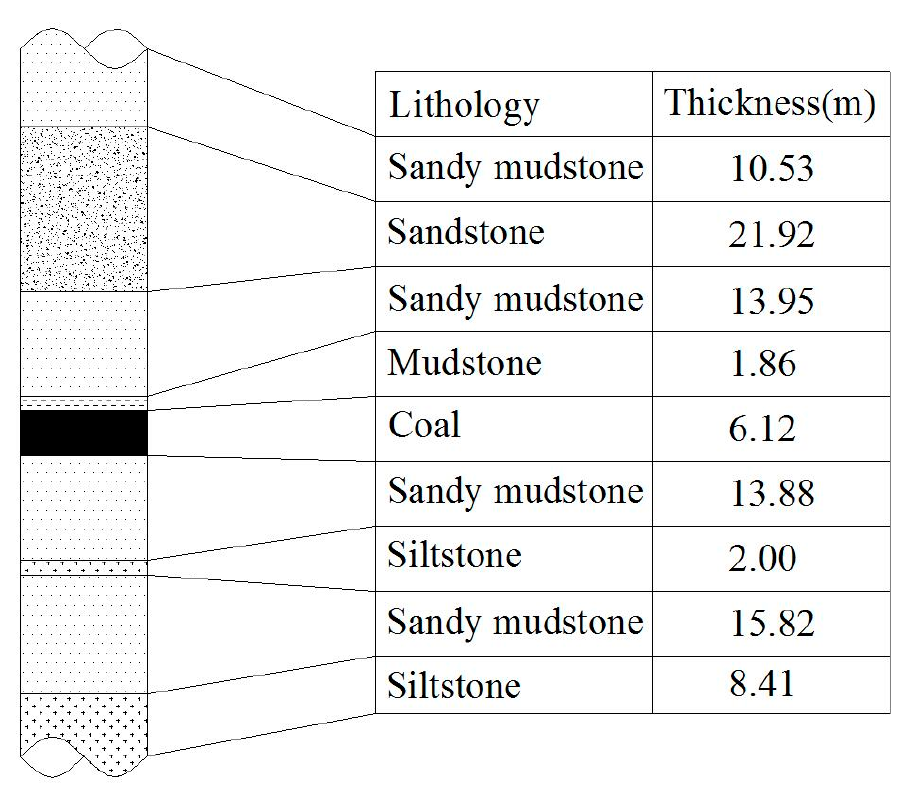
Figure 3. Roof and floor strata information.